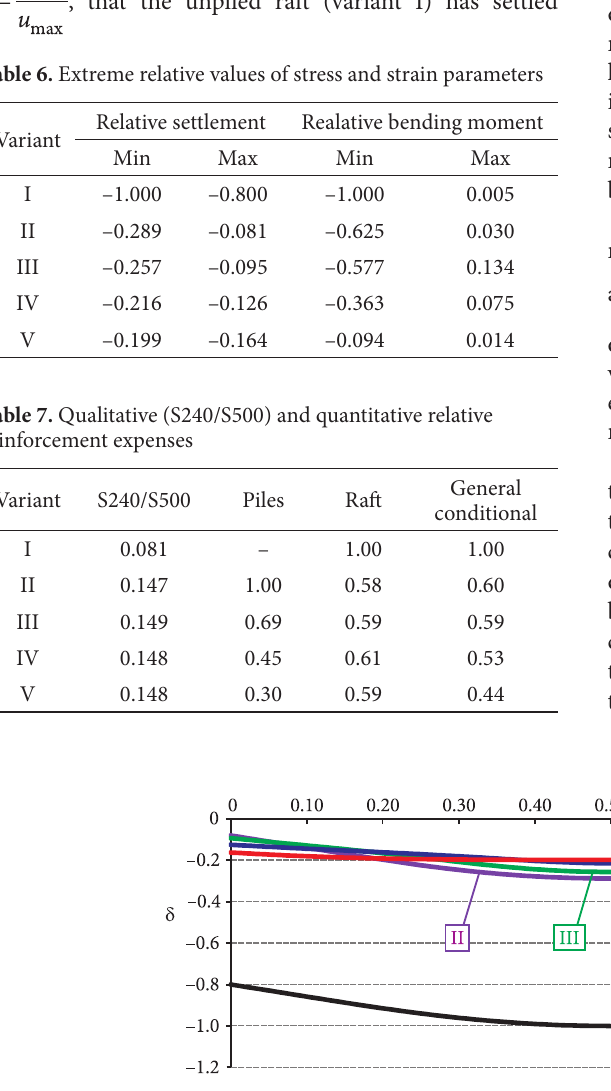
fig. 8. General distribution of relative settlements (δ, from 0 to –1) along the raft central axis (λ, from 0 to 1)